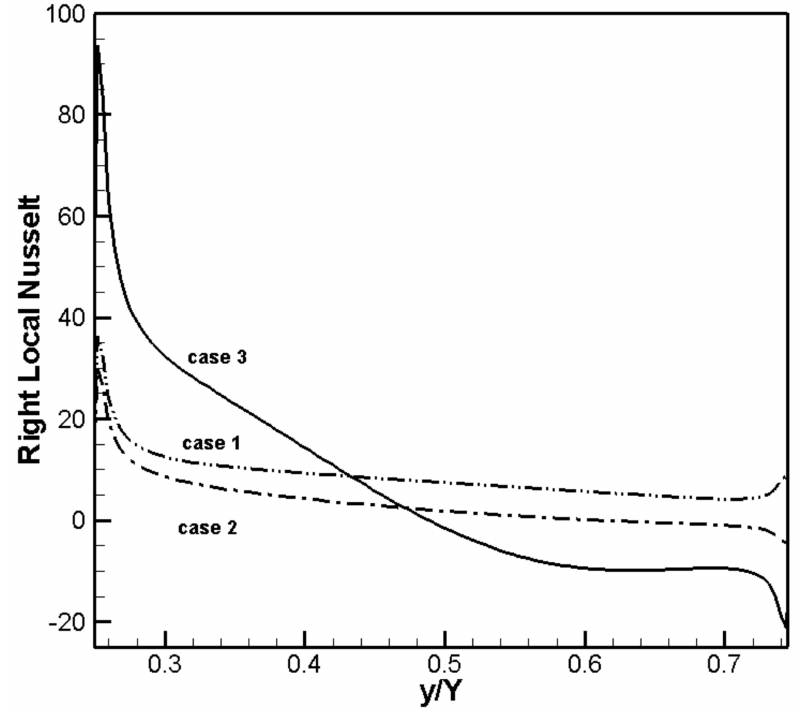
Figure 17. Variation of local Nusselt number along the central partially heated left boundary (Cu- water nanofluid) for different left wall Bcs (boundary conditions) (case 1: Dirichlet constant BC, case 2: linear BC, case 3: sinusoidal boundary condition) at Ra = 10 5 at volume fraction φ = 0.1.